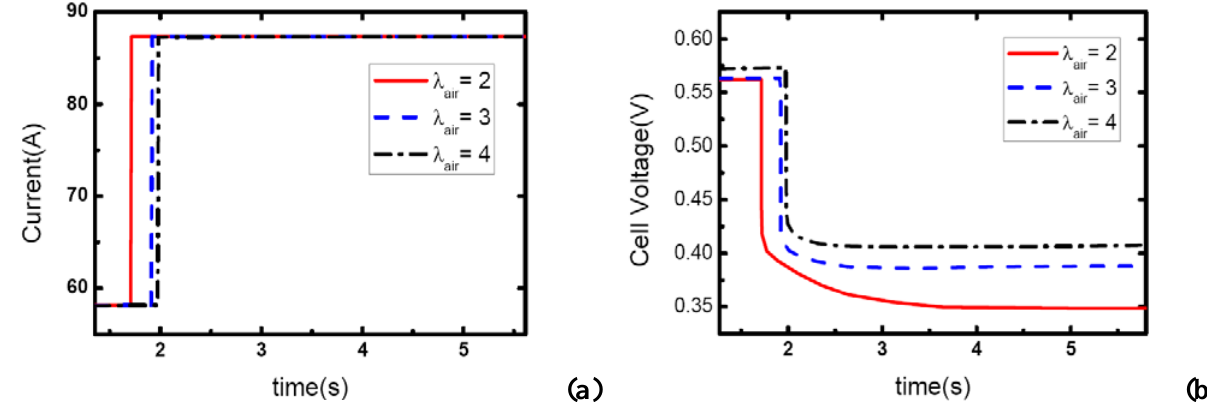
Figure 11. (a) Current change at three different stoichiometric ratios in cathode when the initial current is 57 A, (b) corresponding dynamic responses of voltage.